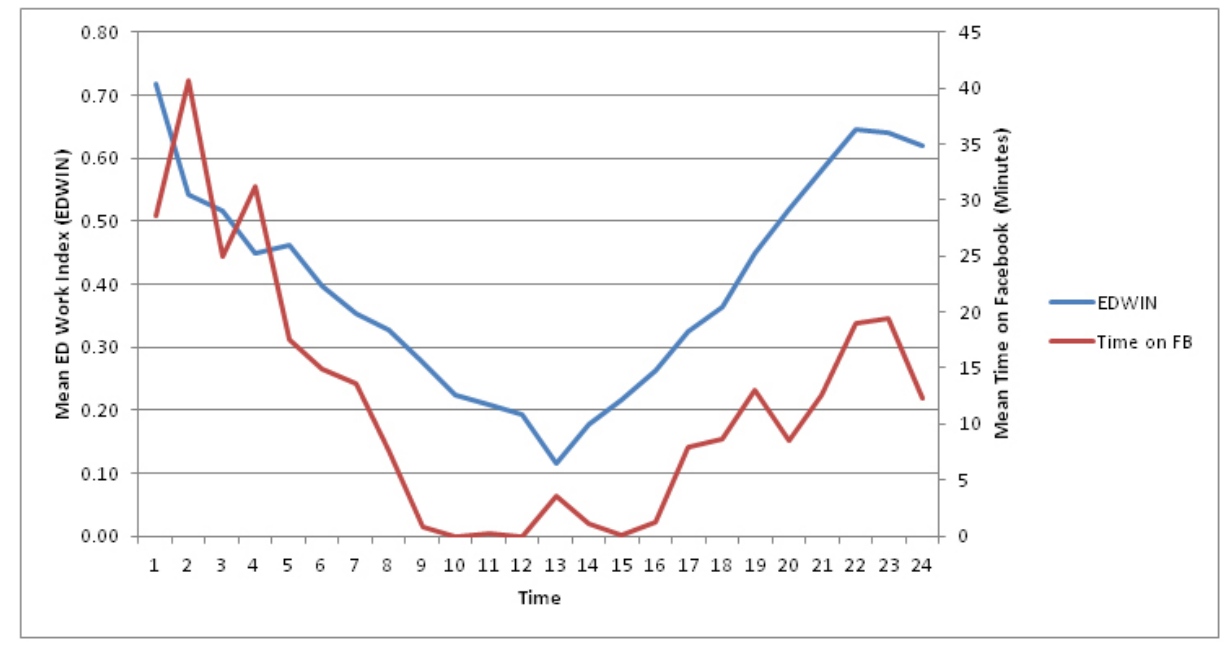
Figure 2. Average time on Facebook and average ED business across 24